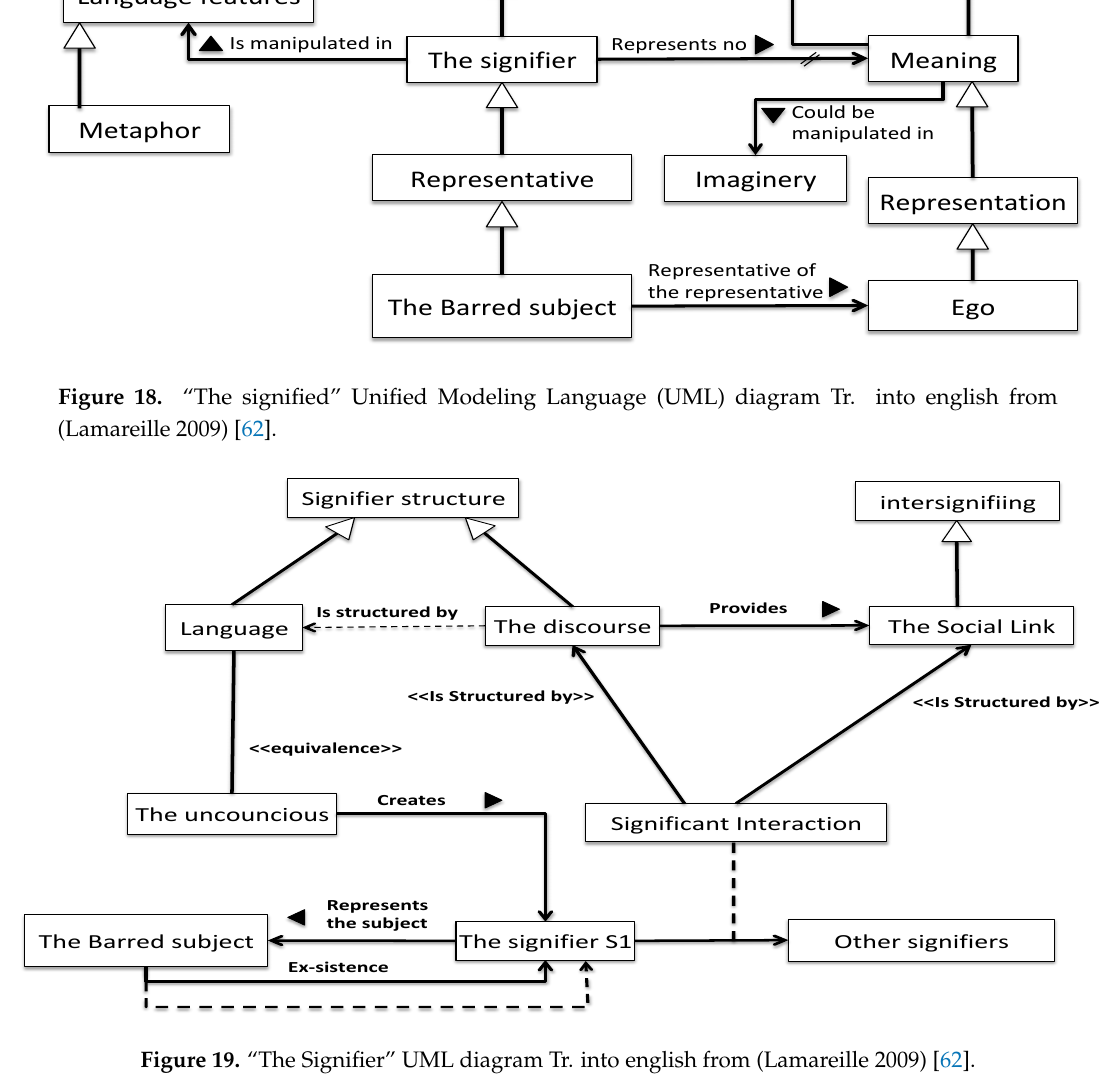
Figure 19. “The Signifier” UML diagram Tr. into english from (Lamareille 2009)